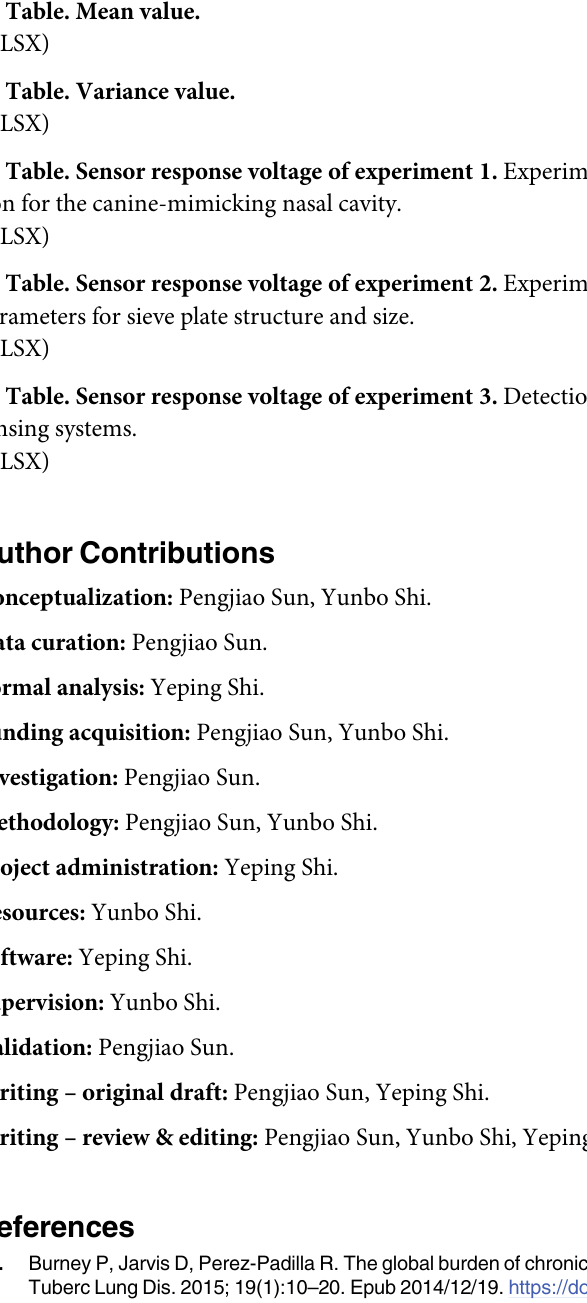
S1 Table. Test results of sensing system mimicking canine nasal. S2 Table. Test results of Sensing system mimicking canine ethmoturbinate. S3 Table. Mean value. S4 Table. Variance value. S5 Table. Sensor response voltage of experiment 1. Experiment of optimal parameter selec- tion for the canine-mimicking nasal cavity. S6 Table. Sensor response voltage of experiment 2. Experiment of selection of optimal parameters for sieve plate structure and size. S7 Table. Sensor response voltage of experiment 3. Detection experiments of three bionic sensing